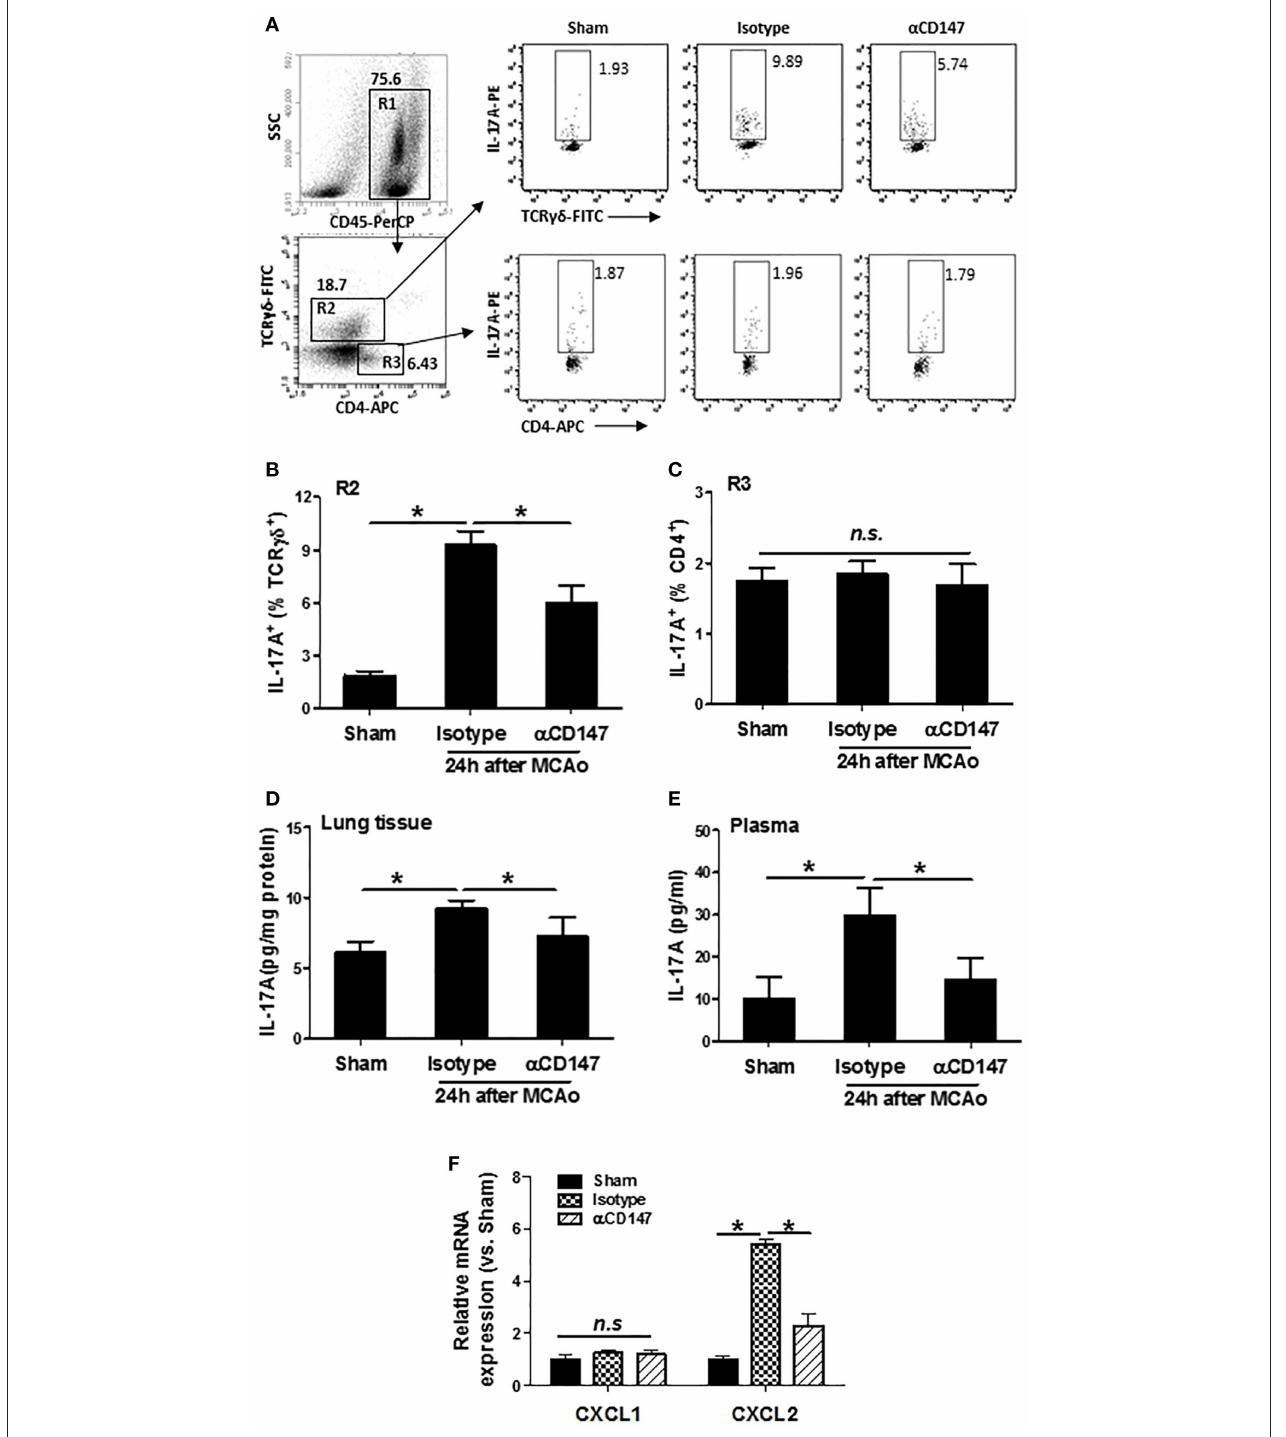
FIGURE 5 | Inhibition of CD147 reduces lung and plasma IL-17A expression after stroke. (A) Representative flow cytometry strategy for gating and identifying IL-17A-producing γδ T cells (R2:CD45 + TCR- γδ + CD4 − ) and CD4 + T cells (R3:CD45 + TCR- γδ − CD4 + ). Lung-infiltrating cell was isolated at 24h after stroke. (B,C) Quantification of lung IL-17A-producing γδ T cells (B) and CD4 + T cells (C) in the indicated groups. n = 6 per group. (D,E) ELISA assay of IL-17A protein concentrations in the lung tissue (D) and plasma (E) at 24h after stroke. n = 6 per group. n.s. indicates not statistically significant. * P < 0.05. (F) Real-time RT-PCR analysis of mRNA expression of the chemokines (CXCL1 and CXCL2) in the lung after stroke. n = 5 per group. n.s. indicates not statistically significant. * P < 0.05.